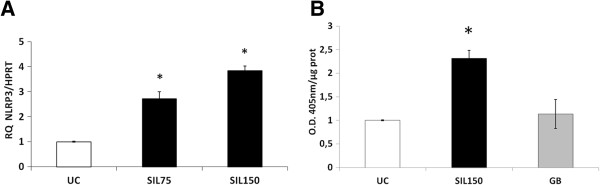
Crystalline silica increases NLRP3 mRNA levels and caspase-1 cleavage products in BEAS-2B cells. A. Bar chart represents relative quantity of NLRP3 mRNA levels after 24 h exposure to 75 × 106μm2/cm2 (SIL75) and 150 × 106μm2/cm2 (SIL150) of cristobalite silica in BEAS-2B cells. *p-value <0.05 compared to UC. B. Caspase-1 enzymatic activity was assayed in cell lysates of BEAS-2B cells exposed to the indicated silica concentrations for 24 h. Glass beads (GB) and unexposed cells (UC) were included as controls. Caspase-1 activities are expressed as arbitrary units (O.D. 405 nm/μg total protein) with *p-value <0.05 compared to UC.